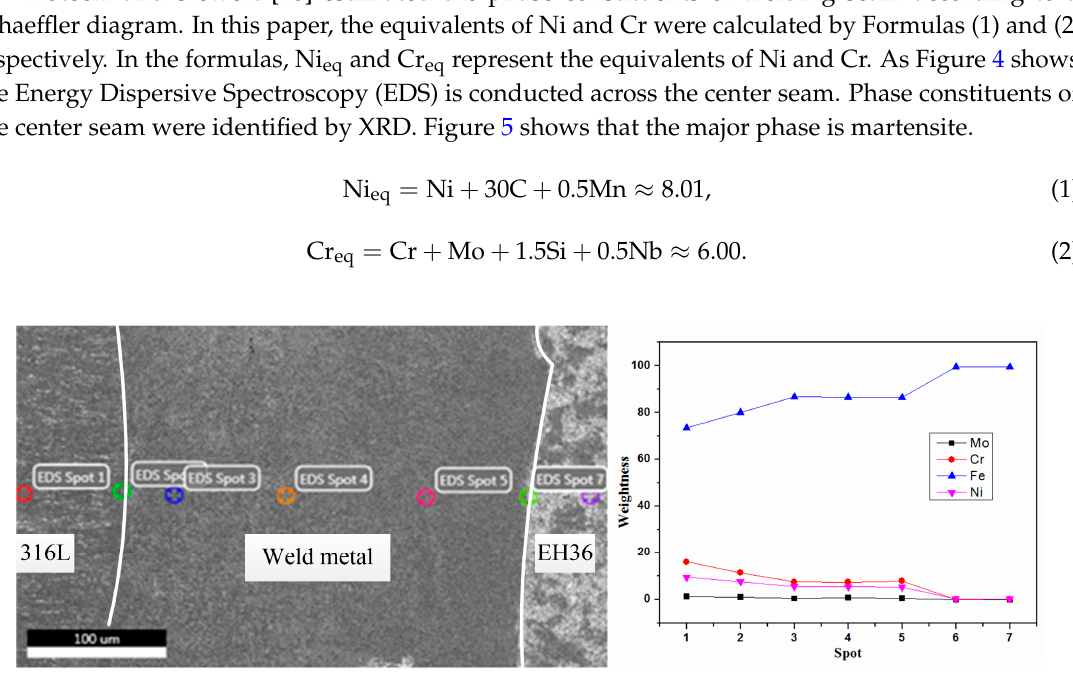
Figure 4. Energy Dispersive Spectroscopy (EDS) test across the weld metal.